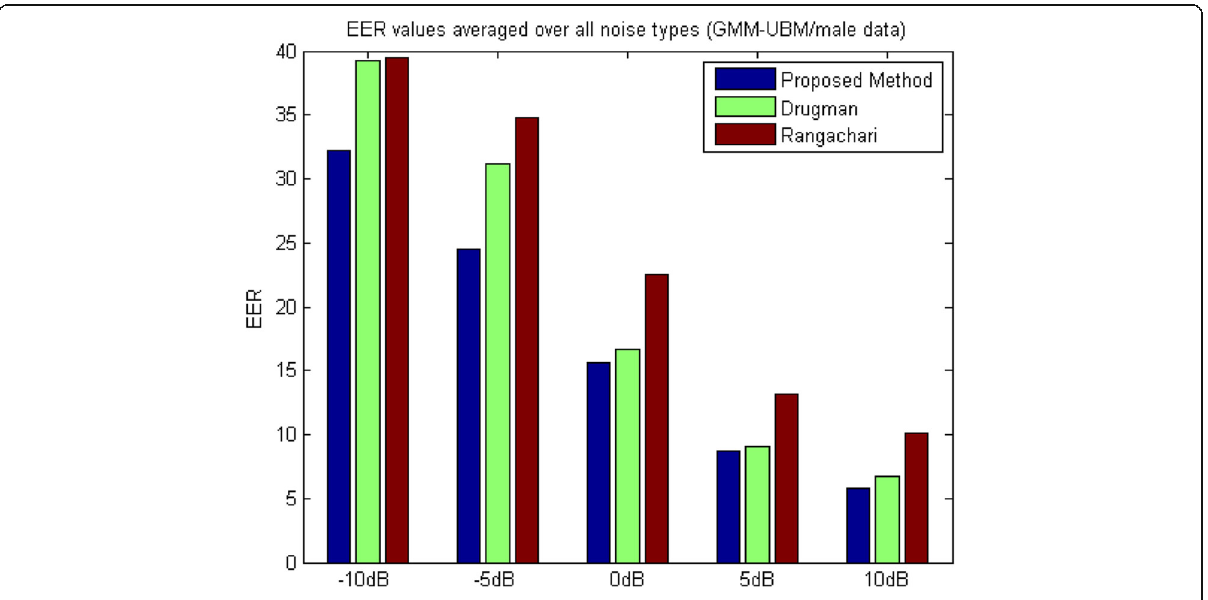
Fig. 7 EER values averaged over all noise types for the male data with GMM/UBM backend